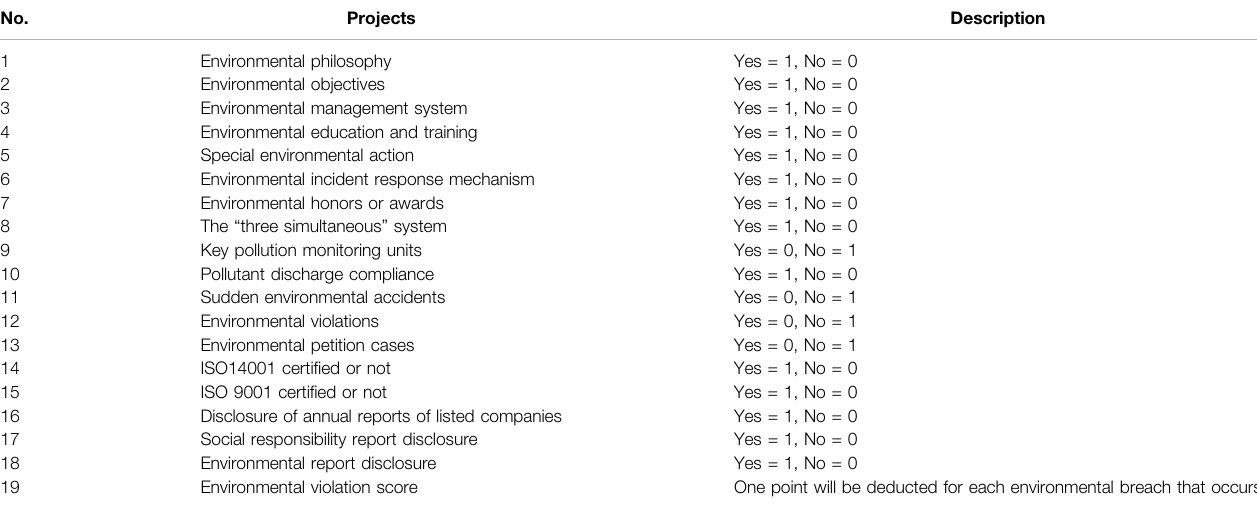
TABLE 7 | Environmental rating